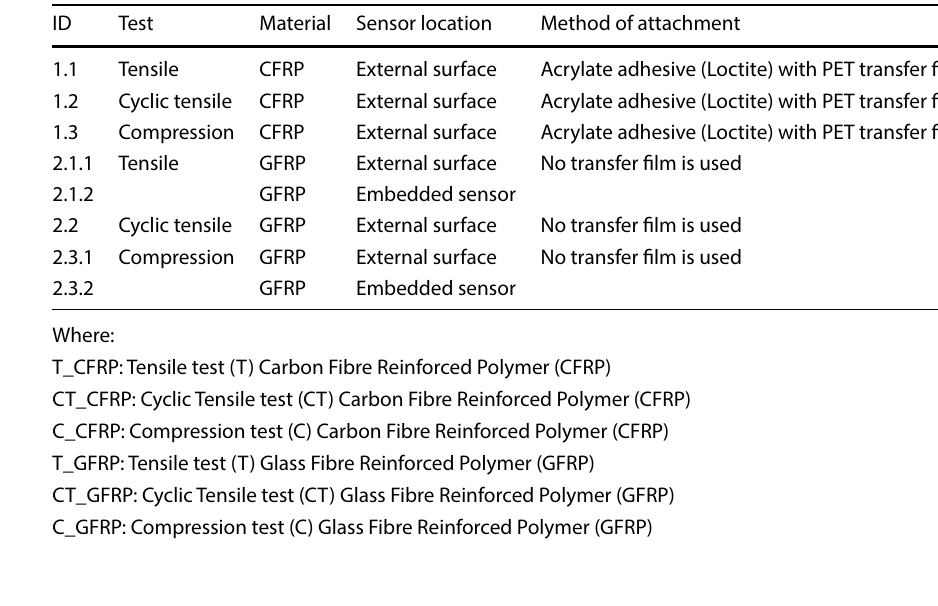
Fig. 8 Graphical illustration showing a the graphene sensor and strain gauges posi- tions on the testing coupons: graphene sensor on the surface (left) and graphene sensor embedded within the composite structure (right) and b the experimental apparatus to evaluate the performance of the graphene-based strain sensing